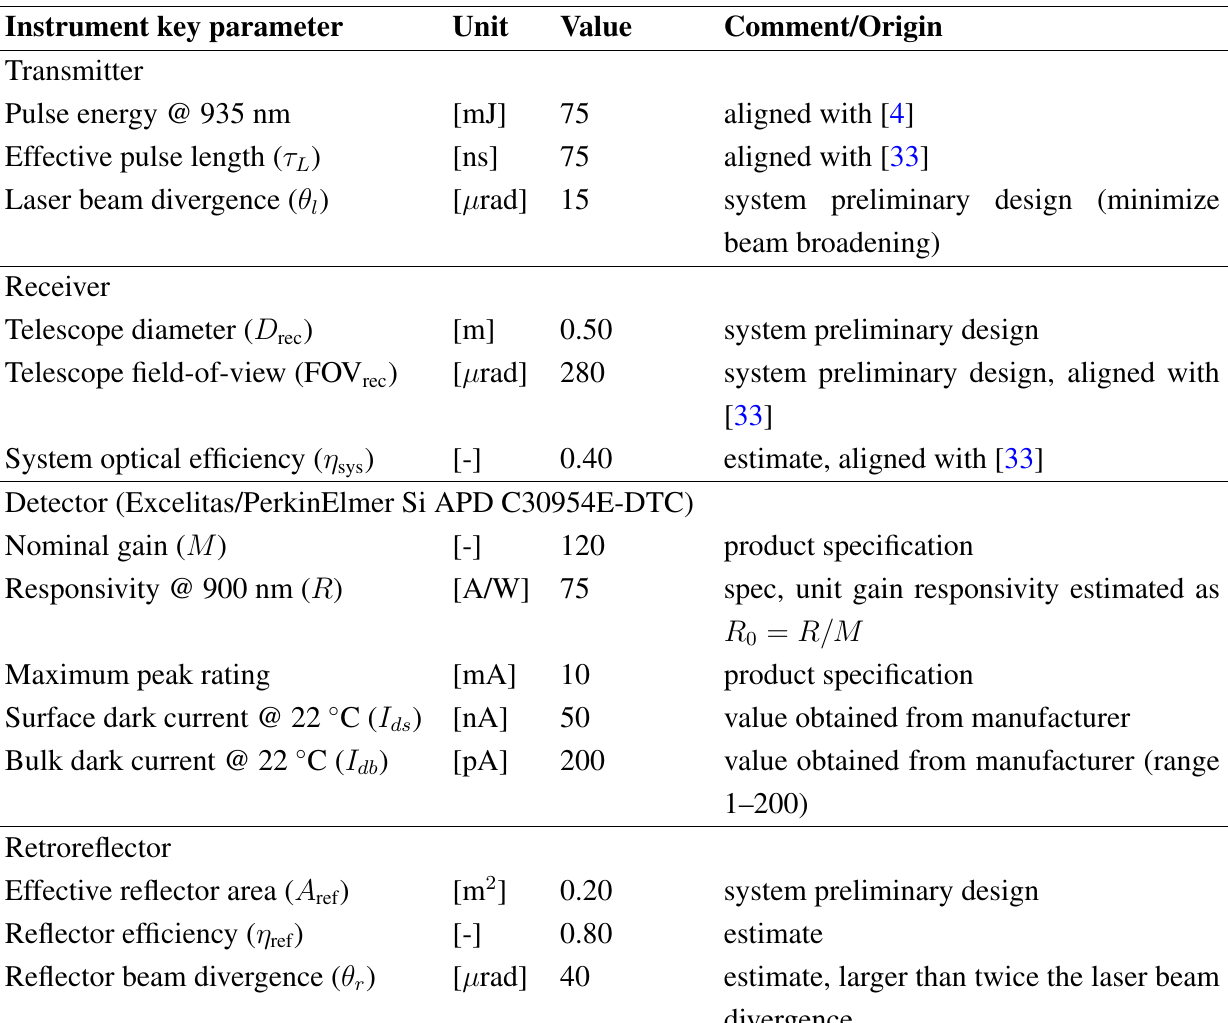
Table 1. Specification of instrument components used in the preliminary performance